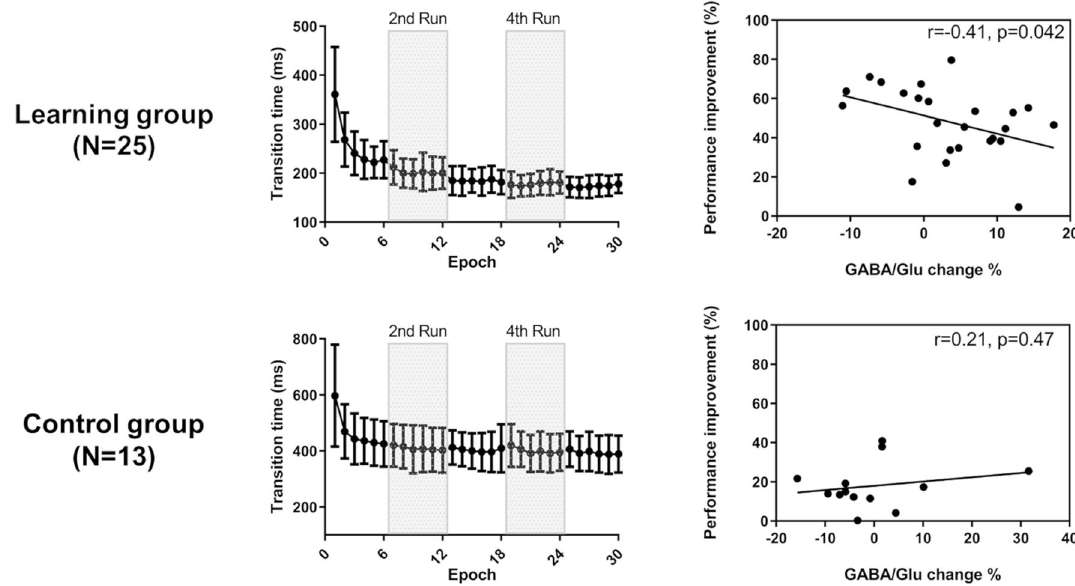
Figure 3. Changes in GABA/Glu ratio with behavioral performance improvement. Task performance change in the motor sequence learning (n = 25, Top Left) and control groups (n = 13, Bottom Left). Task performance was measured using transition time defined as the median time between two correct button responses per epoch. Data are presented as mean ± standard deviation (SD). The right column show the association between GABA/ Glu changes within the right primary motor cortex and performance improvement in the learning (Top Right) and control groups (Bottom, Right).